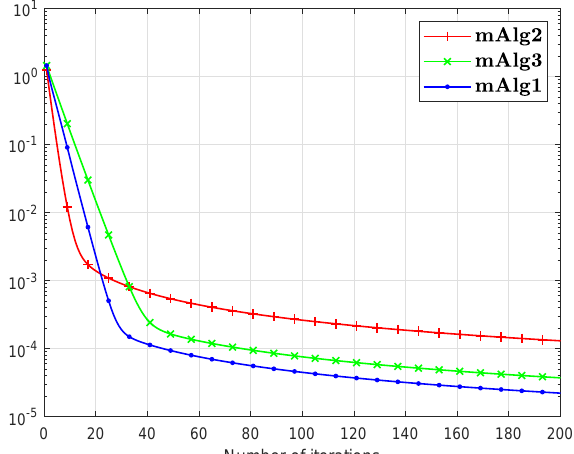
Figure 1. Algorithm 1 compared to Algorithm (60) and Algorithm 3.2 in [34] for R 5 .